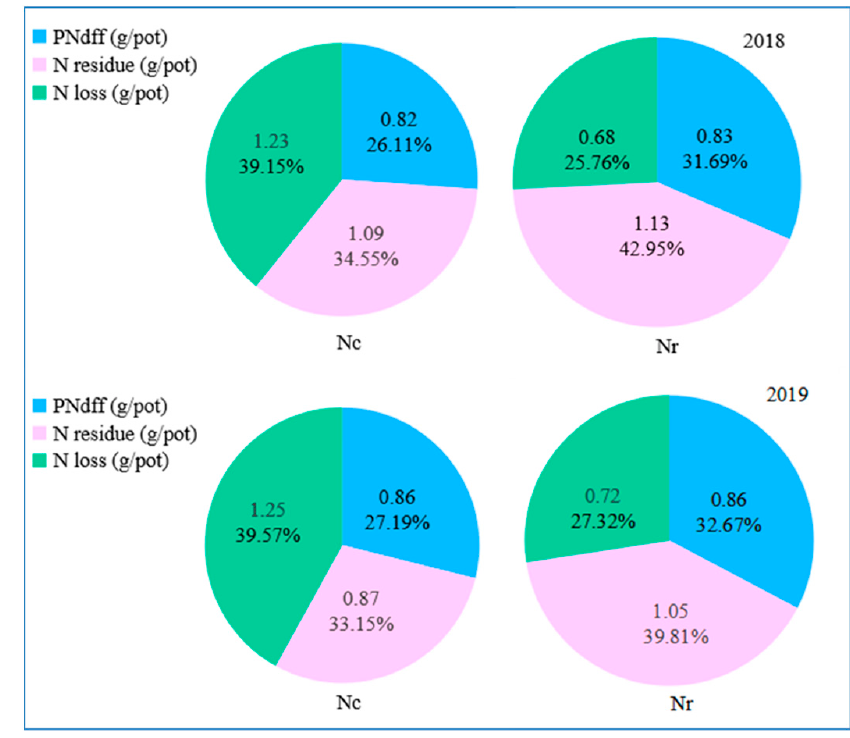
Figure 2. The fate of nitrogen fertilizer in the rapeseed season. In the wheat season, the trend over the two years was consistent (Figure 3). Wheat plants absorbed an average of 0.53 g N/pot (31.96%), 0.63 g N/pot (37.88%) was residual in the soil after harvesting wheat, and the balance, 0.49 g N/pot (29.89%), was lost under conventional 15 N-labeled urea application over two years. The reduced application of 15 N-labeled urea to wheat plants over two years showed that they absorbed an average of 0.50 g N/pot (40.04%), 0.47 g N/pot (38.61%) was residual in the soil after harvesting the wheat, and the other 0.25 g N/pot (21.00%) was lost. Wheat plants absorbed more 15 N-labeled urea under a reduced 15 N-labeled urea